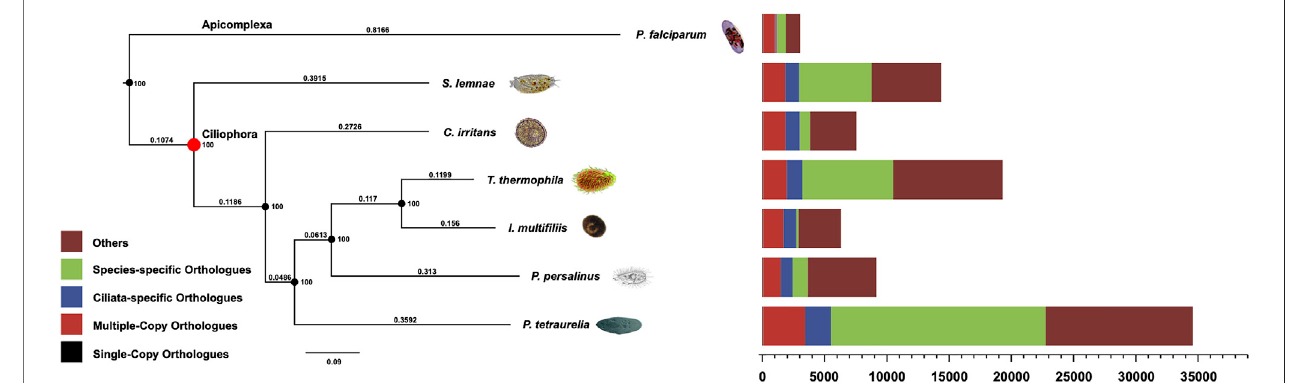
FIGURE 3 | Phylogenetic analysis and distribution of different types of orthologs in representative species ( C. irritans , P. falciparum , P. persalinus , S. lemnae , T. thermophila , I. multi fi liis and P. tetraurelia ). The bootstrap value of all branch nodes indicated the robustness of the phylogenetic tree. The numbers above the branches meaning the sequence difference, which were the product of nucleotide mutation rate and divergence time between